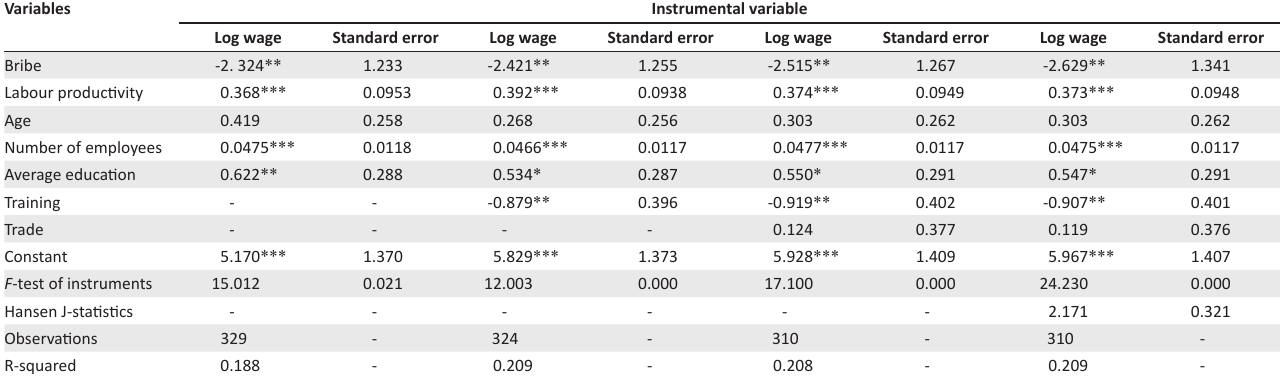
TABLE 5: Effect of bribery on wage payment, instrumental variable estimation. Variables